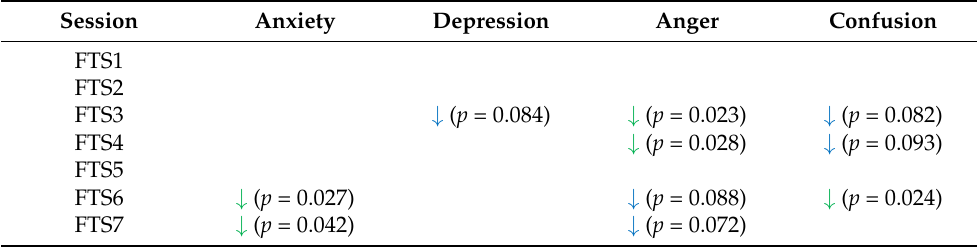
Table 6. Statistically significant differences between outcomes from each forest therapy sessions FTS1 to FTS7 and outcomes from the control session FTSC. Green arrows: p < 0.05. Blue arrows: 0.05 ≤ p < 0.10 (close to significance).